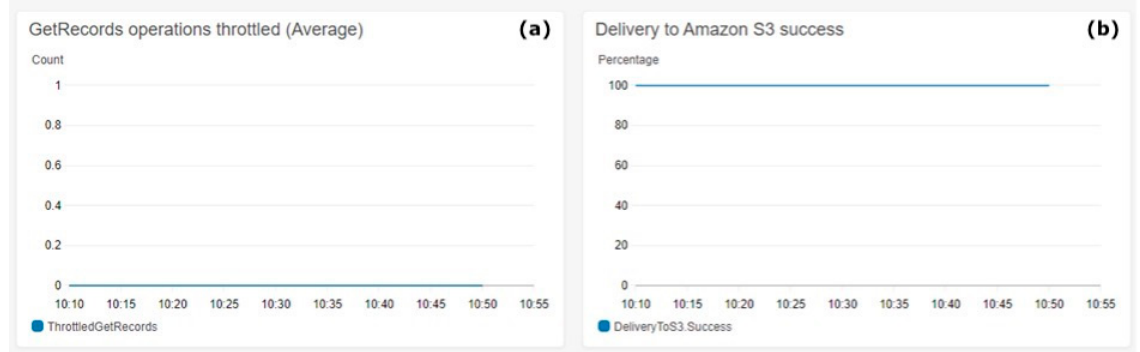
Figure 8. Kinesis Firehose S3 Delivery. (a ) Get records operations throttled (average), ( b ) delivery to Amazon S3 success.